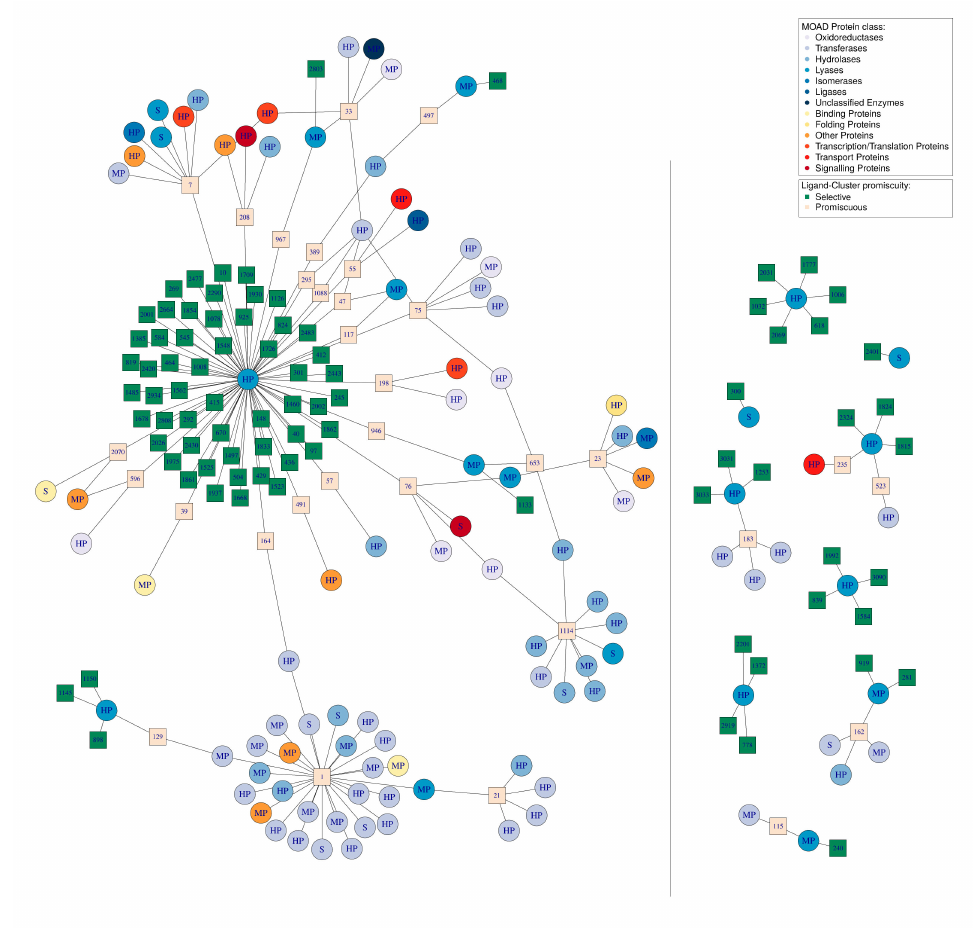
Figure 7. Network of the 20 DBS belonging to the lyase MOAD protein class in the DBS4 dataset, their 117 Ligand–Clusters, and the 84 other DBS from other protein classes that interact with these ligands, resulting in a total of 104 DBS and 220 interactions. Circles represent the DBS; these are colored according to the MOAD protein class to which they belong and are named according to their promiscuity (S for selective, MP for moderately promiscuous, and HP for highly promiscuous). The squares represent the Ligand–Clusters and are colored according to their level of promiscuity (beige for selective, binding to one DBS, or green for promiscuous) and their name is written inside the square. The grey line represents the boundary between the Pocket-Clusters and the Ligand–Clusters. This network visualization was created using the igraph package (see Section